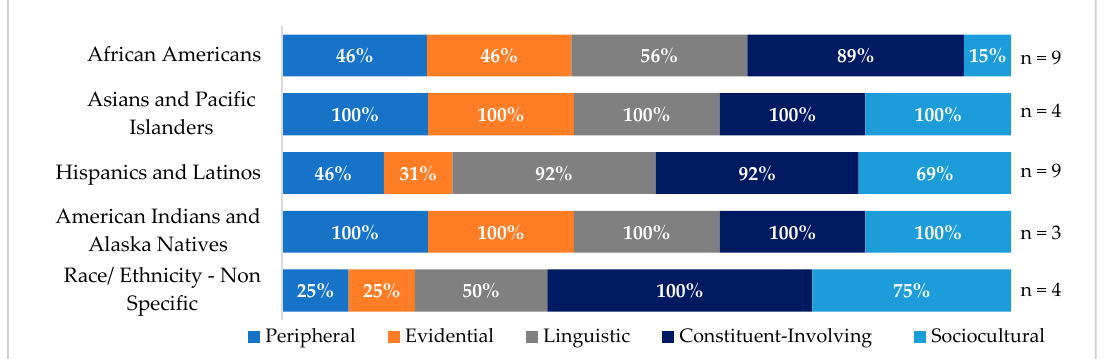
Figure 5. Cultural tailoring use and intersectionality.